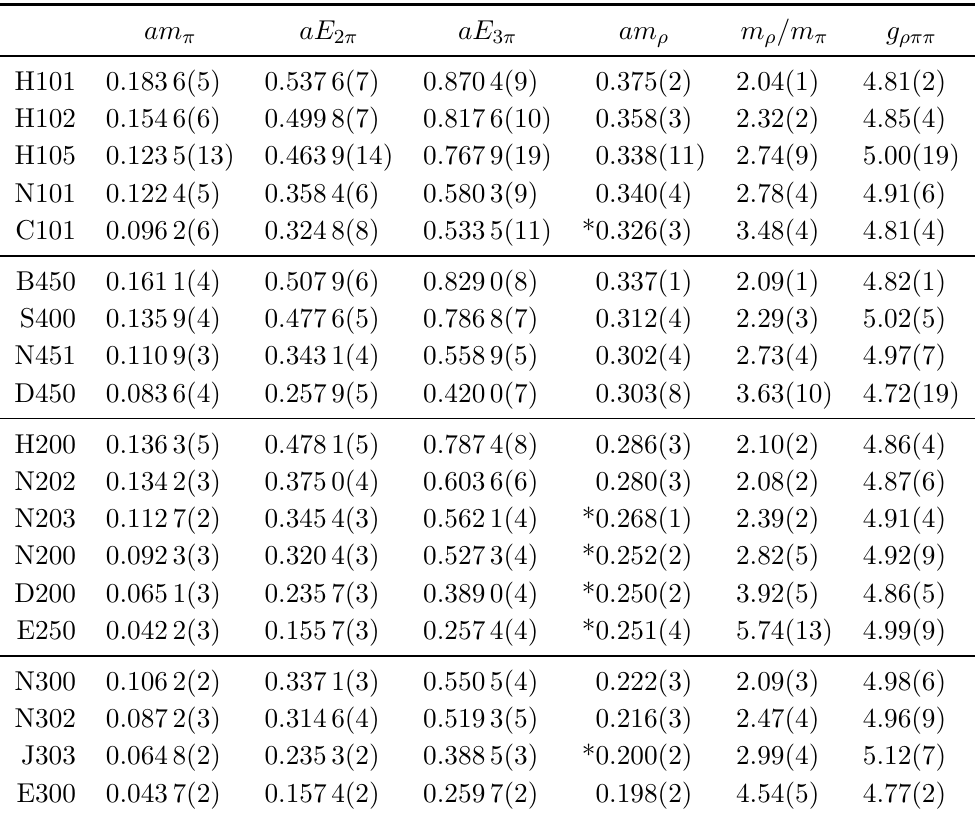
Table 2 . From left to right, label of the CLS ensemble, pion mass, energy of the two- and three-pion non-interacting finite-volume states, and rho meson mass used in the bounding method. E 3 π is obtained employing eq. (3.18). The estimate of m ρ is obtained from a fit to the local-local discretization of the correlator G 33 as described in section 3.7.1, except when a value is available from a dedicated study [88]. In this case, the entry is marked by an asterisk (see also table VII in ref. [8]). In the last two coloumns we list m ρ /m π and g ρππ which serve as input parameters for the Gounaris-Sakurai model used in the MLL-GS method to correct for finite-size effect. For this purpose, we always use the parameters obtained from the fit to G 33